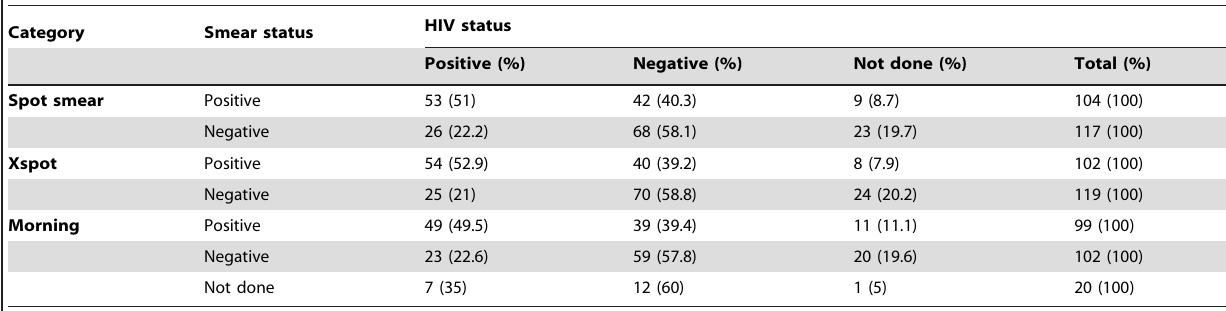
Table 3. Performance of the three samples by HIV